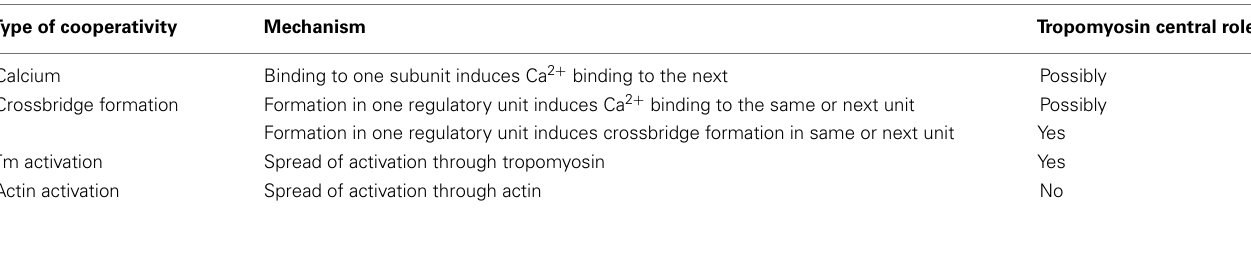
Table 1 | Cooperative mechanisms in muscle regulation where tropomyosin might play a central